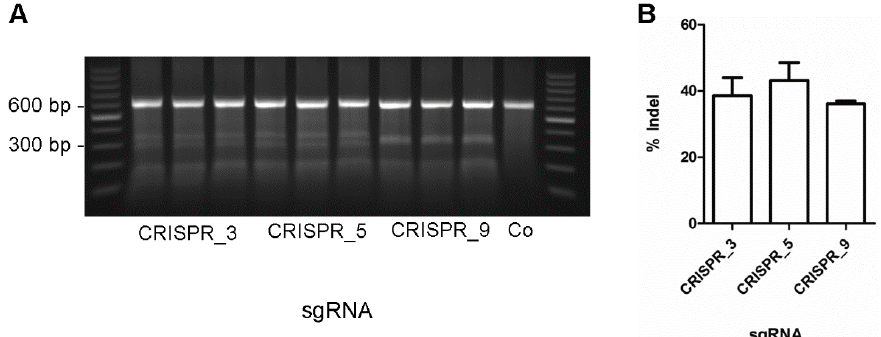
Figure 1. Total genome editing of MYH7 gene. Three single guide RNAs (Clustered Regularly Interspaced Short Palindromic Repeats, CRISPR_3, CRISPR_5, CRISPR_9) were cloned into the pX330-vector. Vectors were transfected into porcine fetal fibroblasts in parallel experiments in triplicates. As a control, cells were subjected to the transfection protocol without CRISPR/Cas9 vector (Co). ( A ) A PCR amplicon of 604 bp of the MYH7 -gene flanking the crRNA (CRISPR RNA, protospacer) binding site PCR product was generated. The strands of the PCR products were denatured, hybridized, and subjected to mismatch-dependent restriction analysis by surveyor nuclease. CRISPR/Cas9